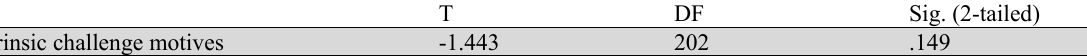
Independent sample test for challenge